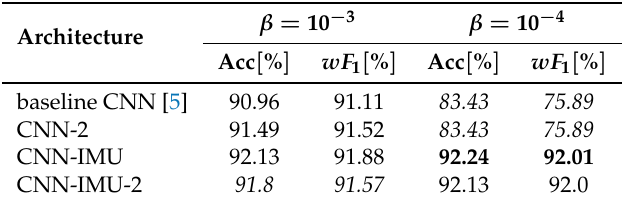
Table 4. Validation accuracies and Weighted F1 for the architectures on the Opportunity-Gestures dataset using two learning rates during training. CNN & CNN-2 architectures with γ = 10 − 4 overfit to the Null class with zero predictions of the other action classes.